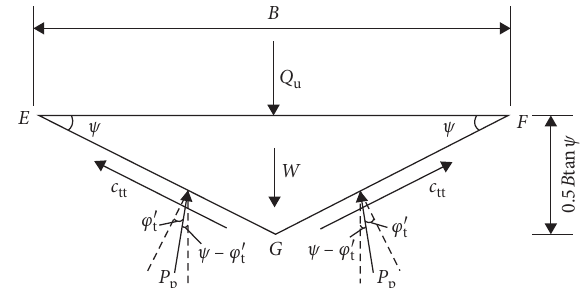
Figure 4: Force analysis of an elastic wedge EFG.